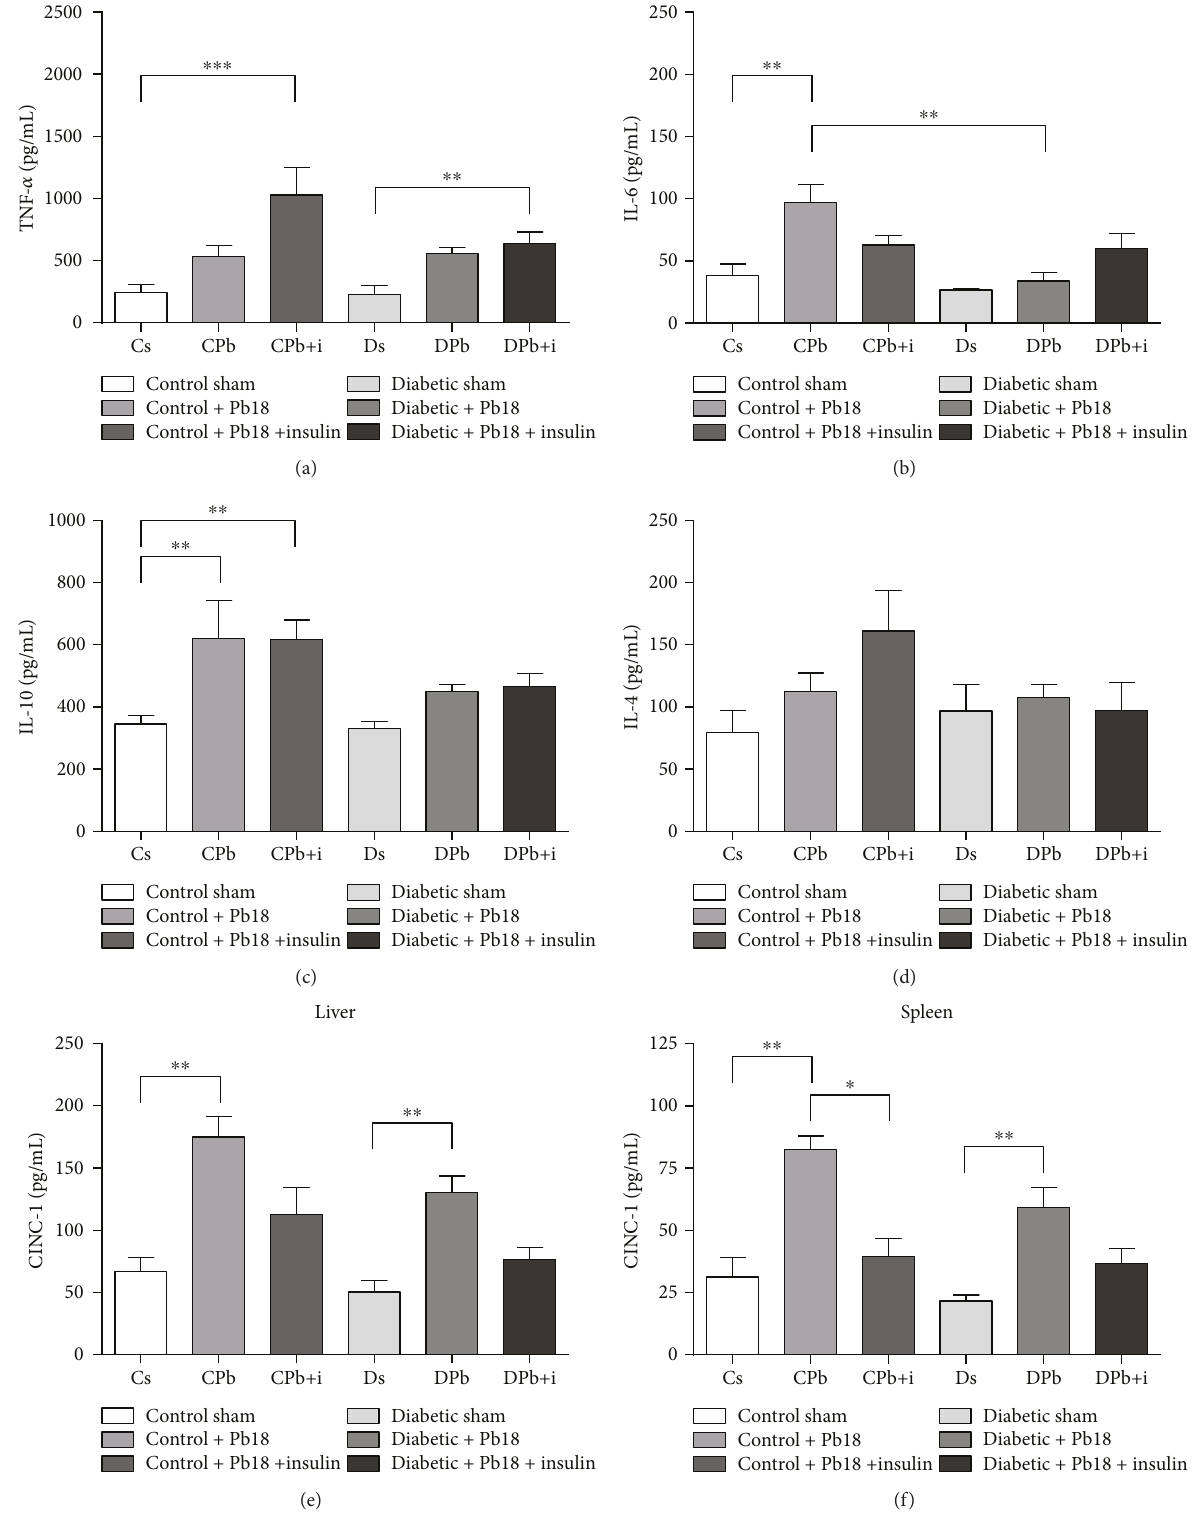
Figure 5: Cytokine and chemokine pro fi les in organ homogenates. Mice were rendered diabetic via injection of alloxan (60 mg/kg i.v.) and infected with P. brasiliensis (1 × 10 6 cells i.t.). Tissue samples were obtained 55 days after alloxan injection and 45 days after the incubation period. Five animals were used for each group. Values are the means ± SEM. ∗ p < 0 05 ; ∗∗ p < 0 01 ; ∗∗∗ p < 0 001 . (a – d) Cytokine analysis in lung homogenates; (e) CINC-1 concentration in the liver; (f) CINC-1 concentration in the